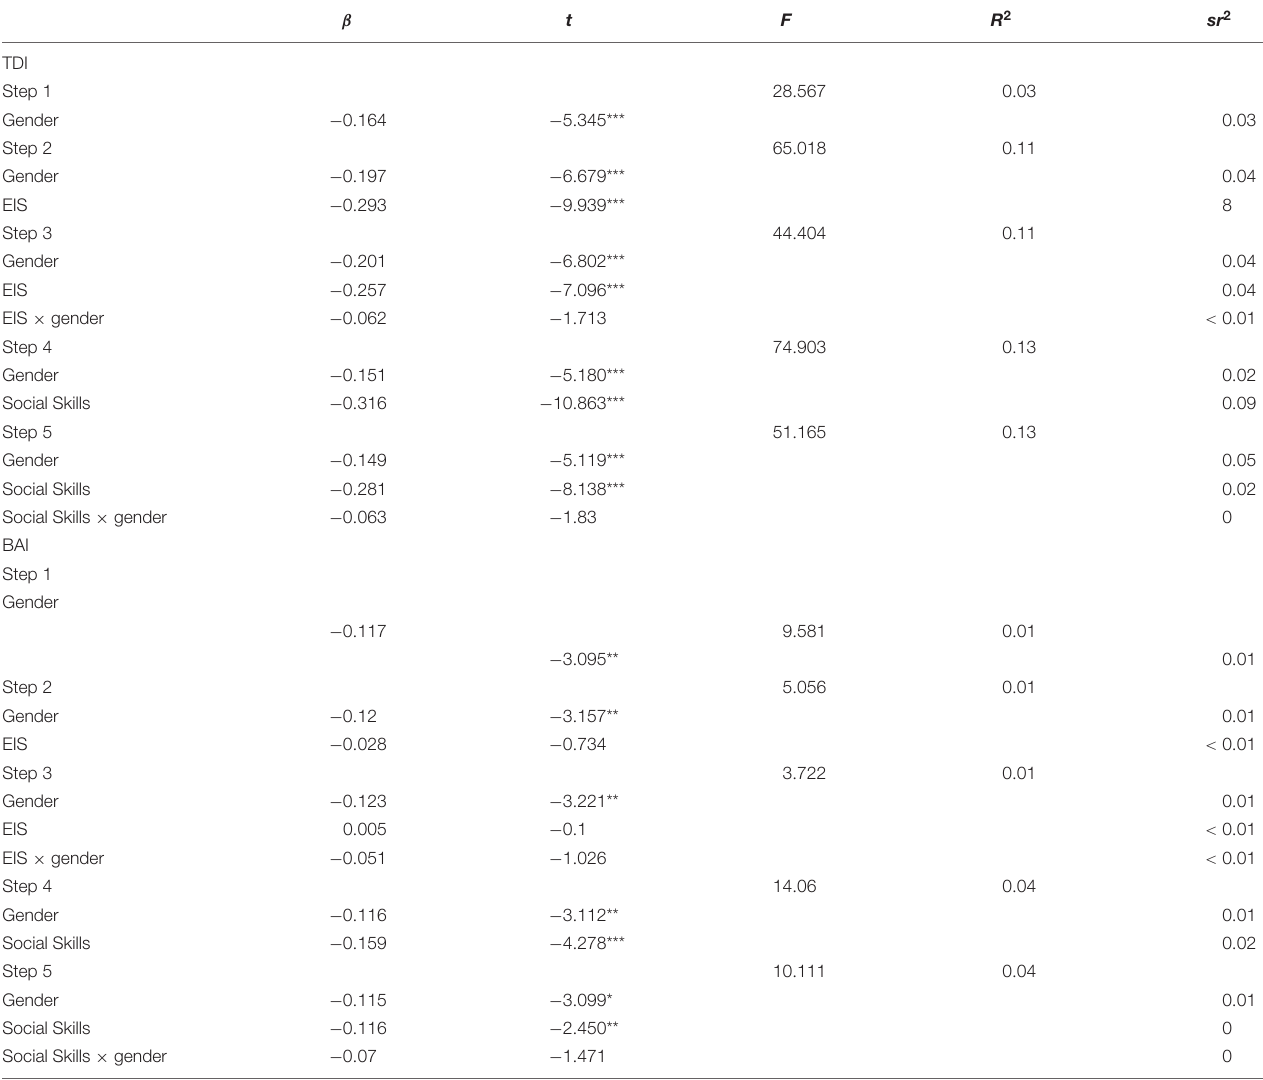
TABLE 7 | Moderating effect of gender on the relationship between EI, depression and